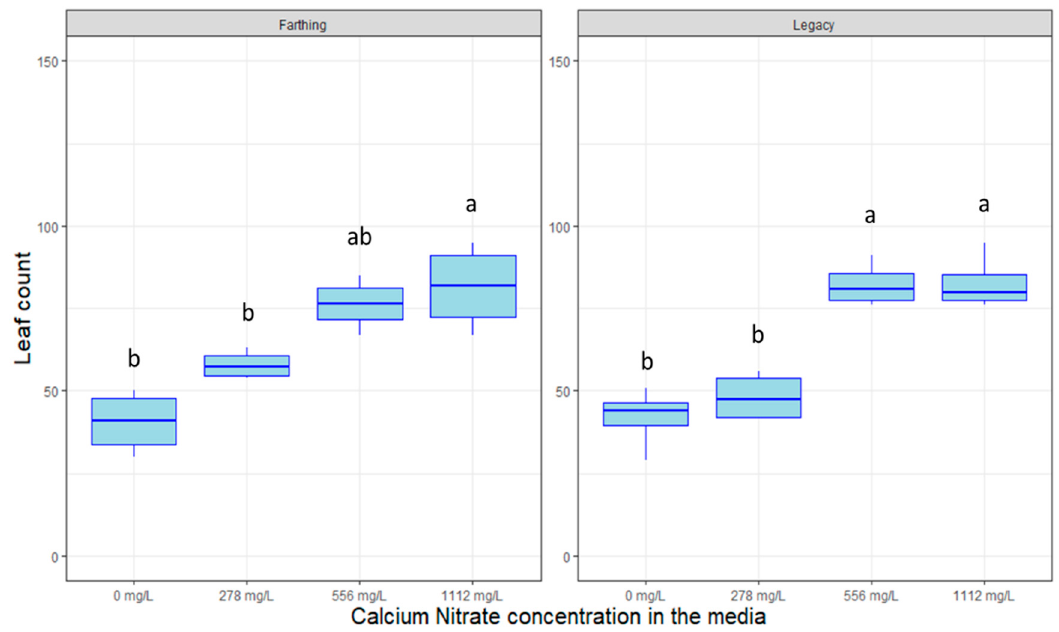
Figure 3. Box plot distribution of the effect of calcium nitrate concentration on leaf proliferation of blueberry genotypes “Farthing” ( left panel) and “Legacy” ( right panel) grown in tissue culture. Letters above boxplots indicate multiple comparison test. Treatments with the same letters are not statistically different at alpha = 0.05.